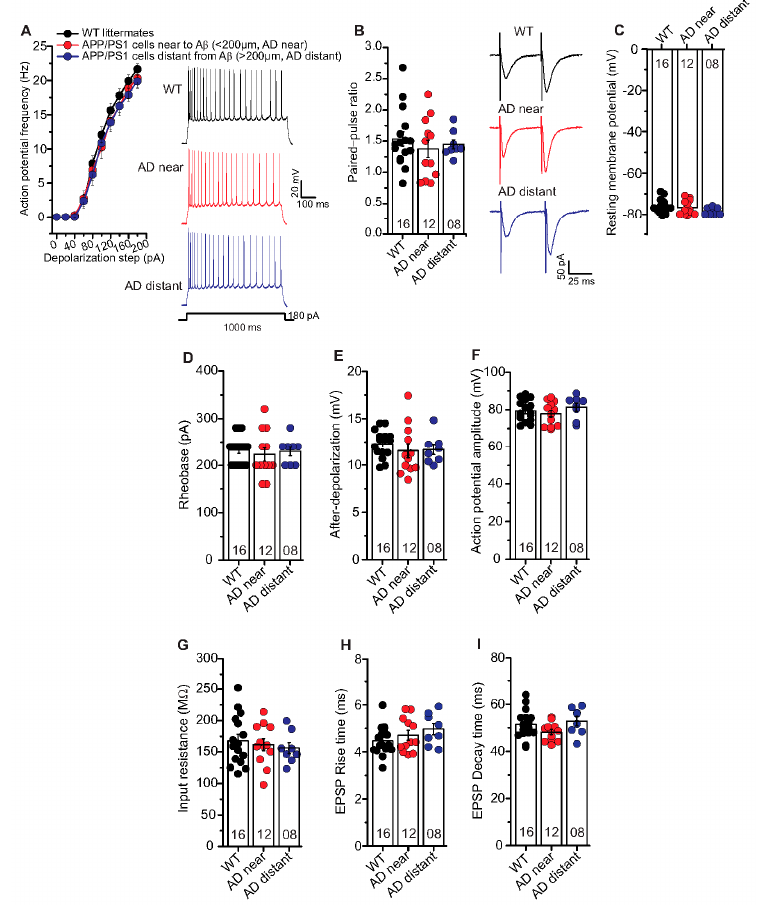
Figure 5. Unaltered basal electrical and synaptic properties of CA1 pyramidal neurons in the vicinity of A β plaques in APP/PS1 mice. Whole cell patch clamp recordings (current clamp except for paired-pulse facilitation recorded in voltage clamp) from CA1 neurons in acute hippocampal slices near to A β plaques in APP/PS1 mice (<200 µm, AD near, red circles), CA1 cells distant from A β plaques in APP/PS1 mice (>200 µm, AD distant, blue circles), and CA1 neurons from WT littermates (black circles). ( A ) The AD near and AD distant groups showed similar intrinsic excitability compared to age-matched WT littermate mice (ANOVA; p = 0.07). Insets: action potentials (APs) firing in CA1 neurons in response to 180 pA (for 1000 ms) somatic current injection from WT, AD near and AD distant groups. ( B ) Paired-pulse ratio (PPR) at SC-CA1 synapses in AD near and AD distant group was similar to PPR in WT littermates ( p = 0.62). Insets: PPR at inter-stimulus interval of 50 ms in CA1 pyramidal cells from WT, AD near and AD distant groups. Hippocampal CA1 neurons from AD near, AD distant group showed similar resting membrane potentials (( C ); p = 0.26), rheobases (( D ); p = 0.81), AP amplitudes (( E ); p = 0.45), after-depolarizations (( F ); p = 0.55), input resistances (( G ); p = 0.73), EPSP rise times (( H ); p = 0.23), and EPSP decay times (( I ); p = 0.14) compared to WT littermates. Digits in the bars represent the number of recorded neurons per condition, at least from three different animals per group. Data displayed as mean ± SEM. Multiple comparisons were performed with